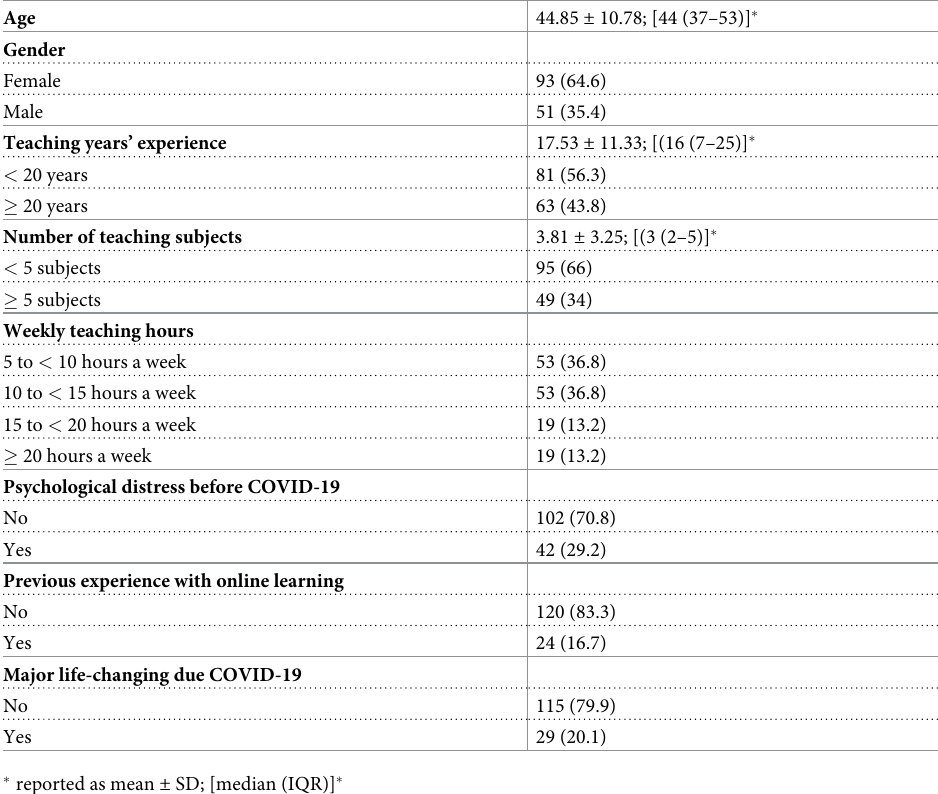
Table 1. Demographic data of the participants, frequencies reported as N